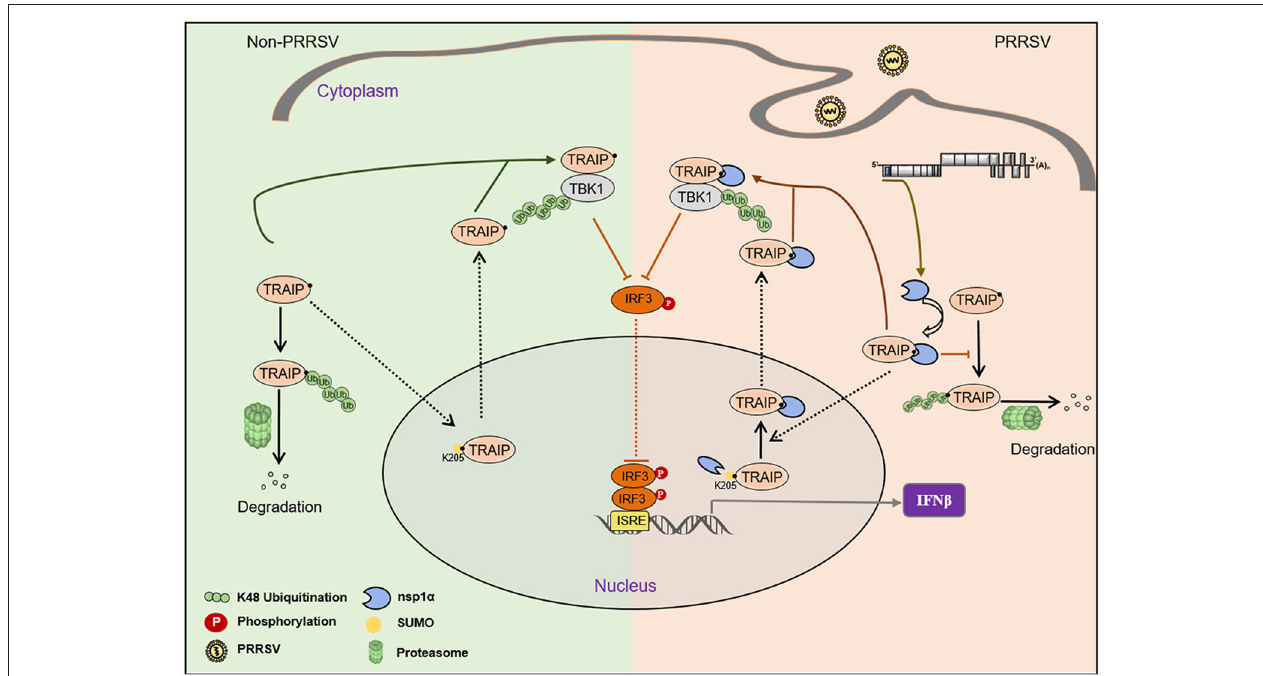
FIGURE 11 | Proposed model for the regulation of the interaction of PRRSV nsp1 α with post-translational SUMO modification of TRAIP. Compared to non-PRRSV infection model, PRRSV-nsp1 α alters the role of TRAIP in cellular life activities by modulating post-translational modifications of proteins. (I) PRRSV infection inhibits SUMOylation and self-ubiquitination of TRAIP, resulting in excessive enrichment of TRAIP in the cytoplasm. (II) Enrichment of cytoplasmic TRAIP leads to excessive K48 ubiquitination and degradation of TBK1, resulting in reduced phosphorylated IRF3 and type I interferon